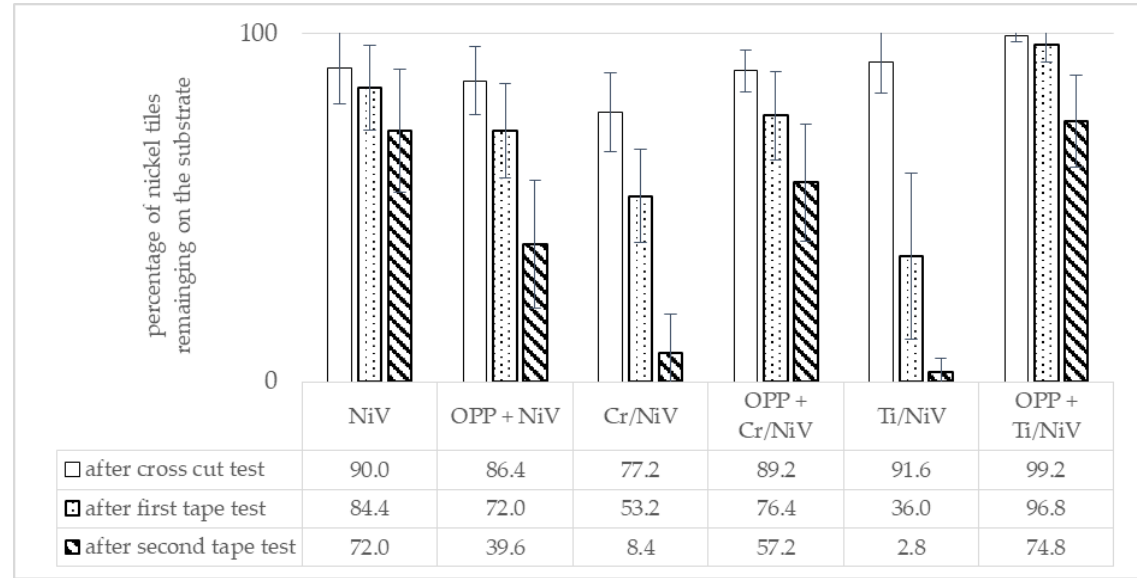
Figure 2. Pictures of a test specimen (Cr/NiV physical vapor deposition layer with previous oxygen plasma pretreatment) after different adhesion tests stages, tile size is 1 mm × 1 mm: ( a ) after cross-cut adhesion test; ( b ) after tape-test with tape A; ( c ) after tape-test with tape B; ( d ) corresponding tape A with adhering nickel tiles; ( e ) corresponding tape B with adhering nickel tiles. (*: images are flipped horizontally to highlight the complementary character of specimen and corresponding piece of tape).